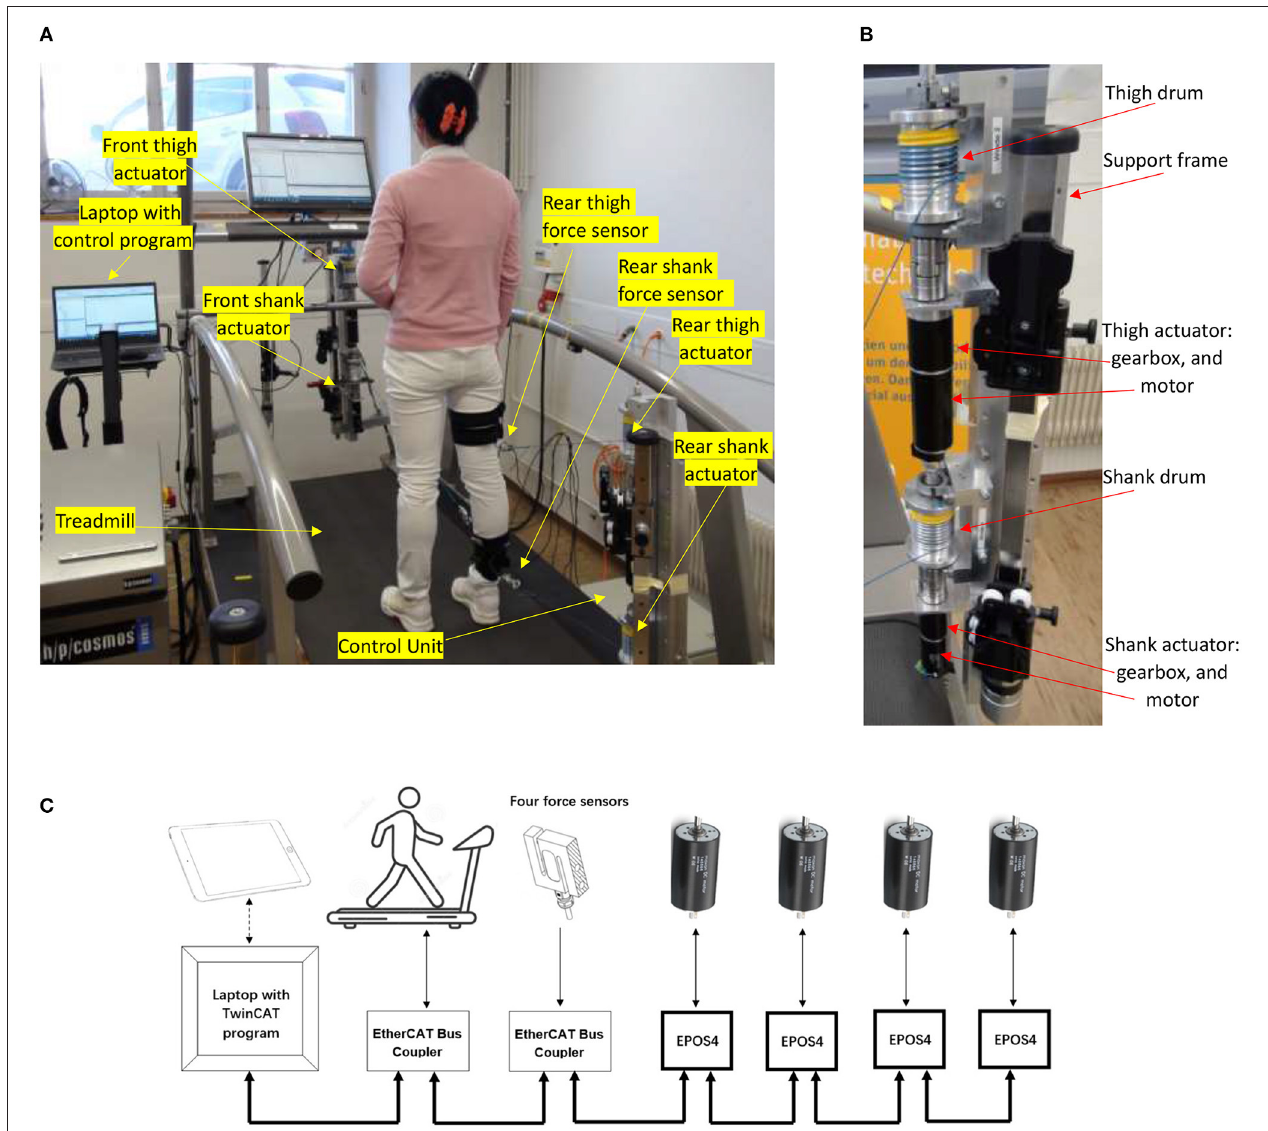
FIGURE 1 | The active cable-driven robotic system. (A) The physical system with a participant. The modified robowalk expander units are at the front-right and rear-right. (B) Modified expander unit with support frame and two actuators (rear-right). (C) The communication structure.